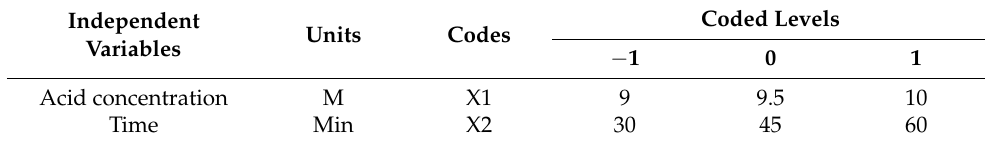
Table 1. Codified values and independent variables used for optimization.